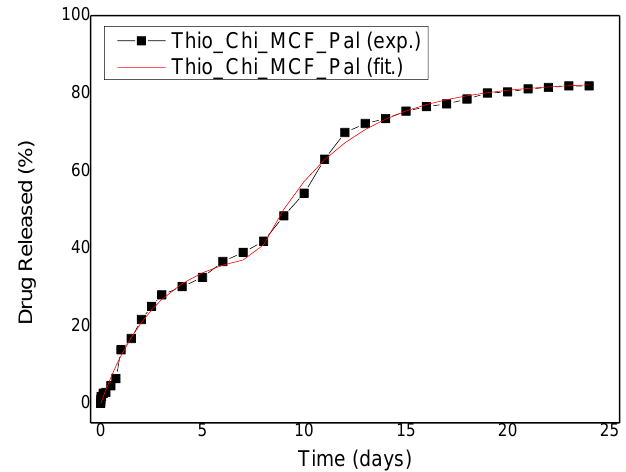
Figure 11. Paliperidone release profile for thiolated MCF particles. The experimental data are shown as symbols and the fitting data as a continuous line.